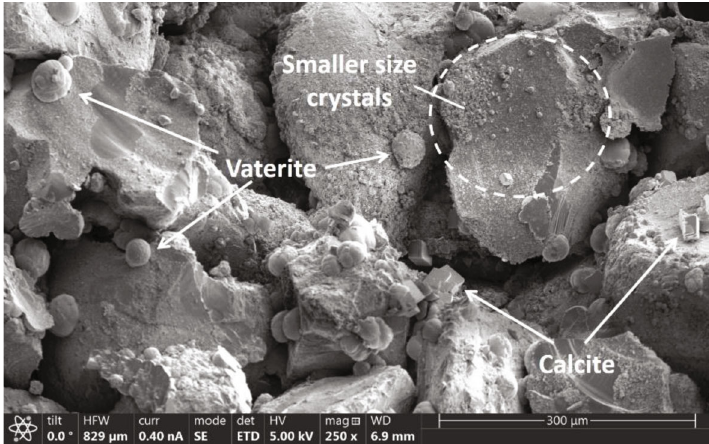
Figure 6: Crystal characteristics and distribution of calcium